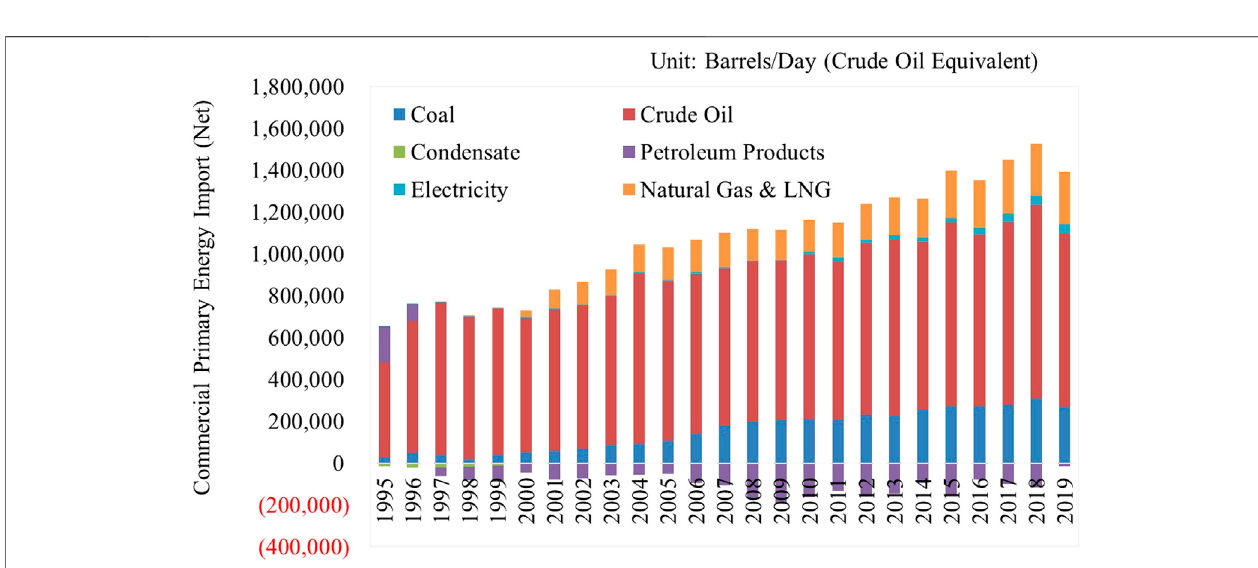
FIGURE 3 | Commercial primary energy import (net) (EPPO,